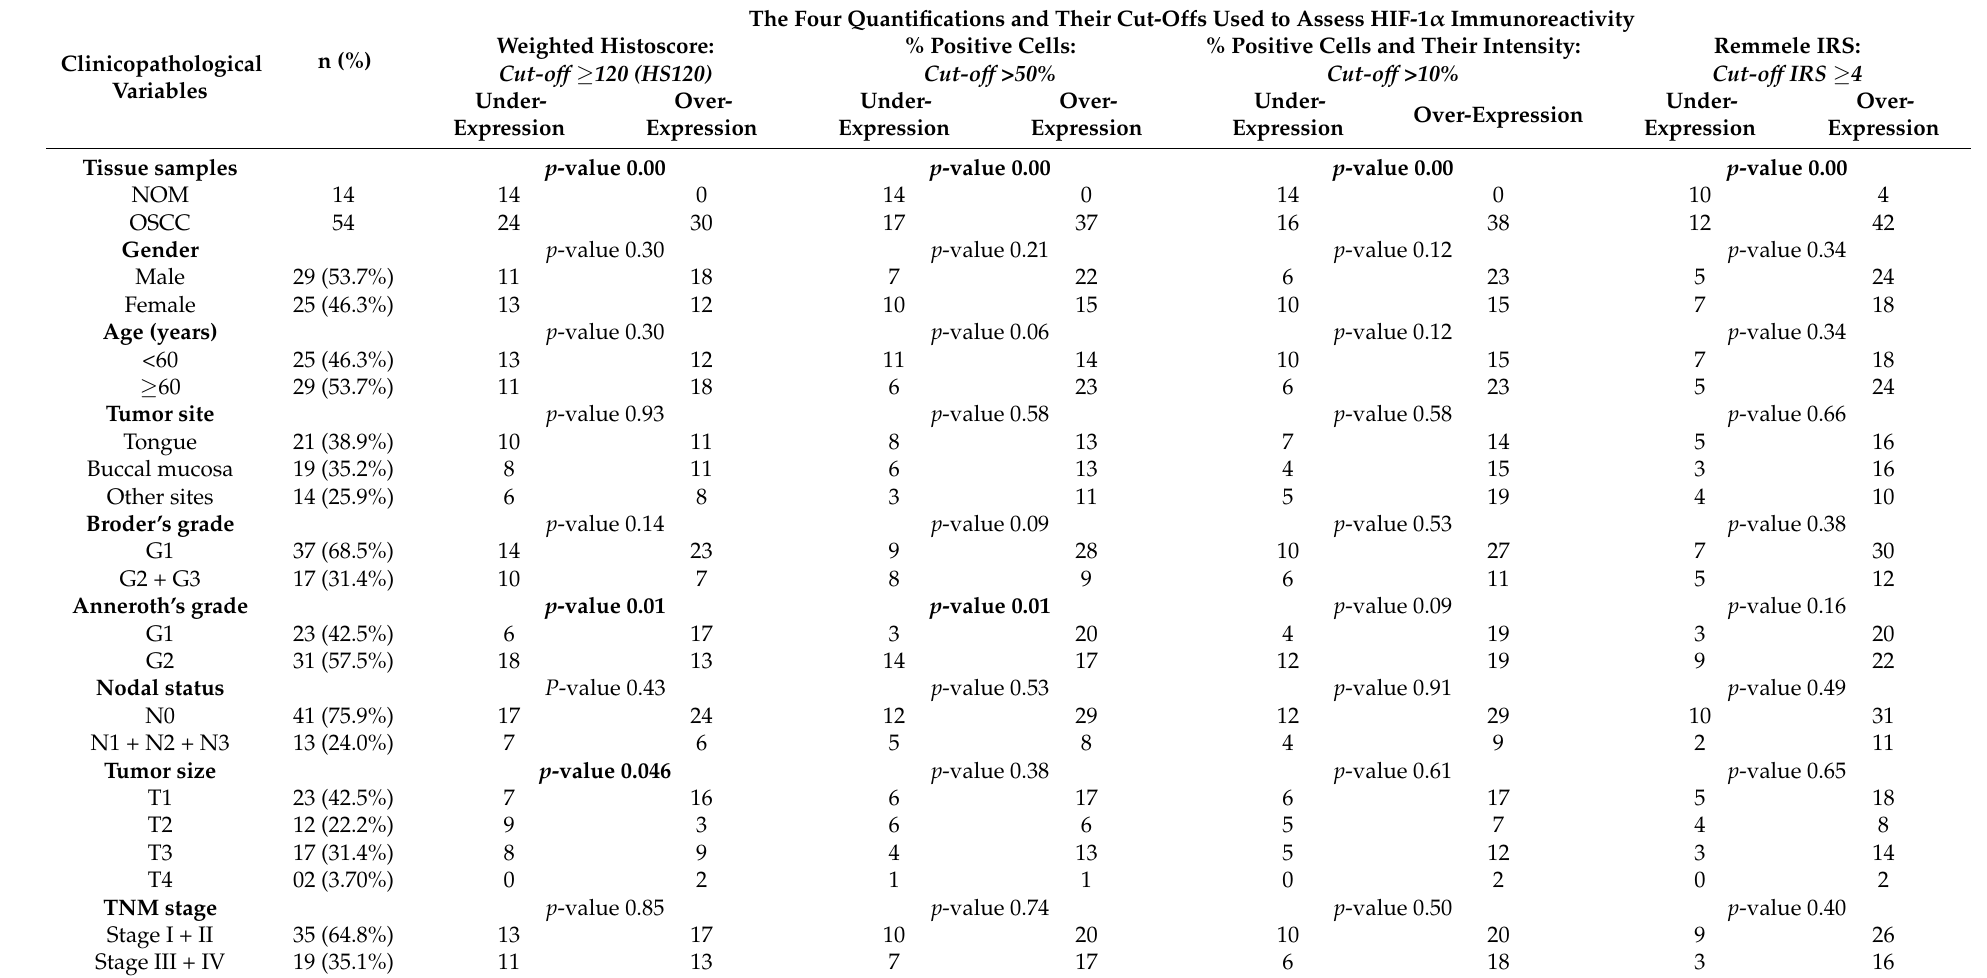
Table 4. Clinical, histopathological, and immunohistochemical data of OSCC specimens and their associations with HIF-1 α